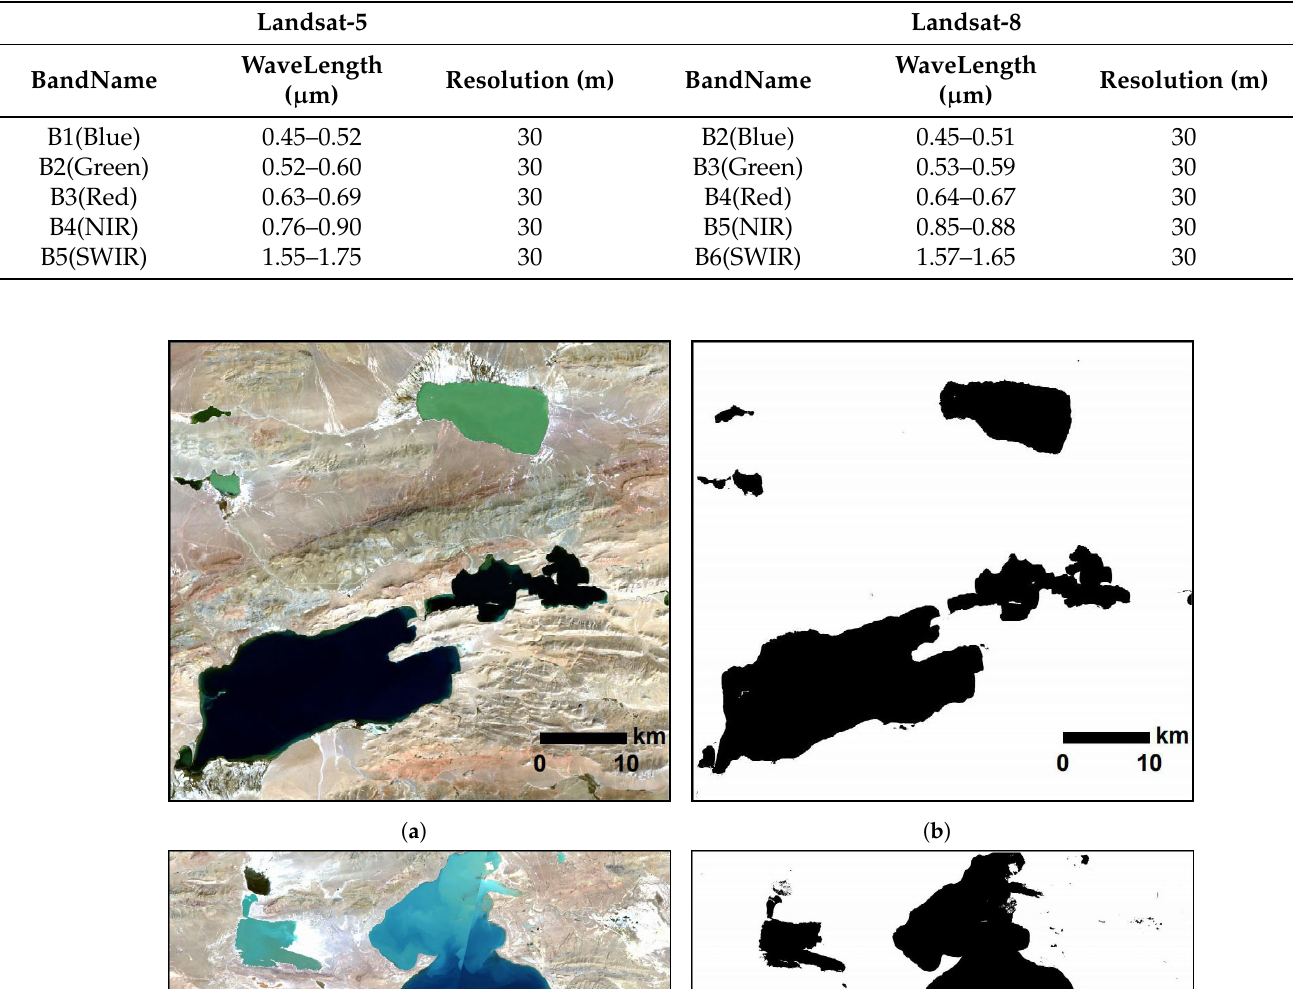
Table 1. Band parameters of Landsat-5 and Landsat-8 used in this study.